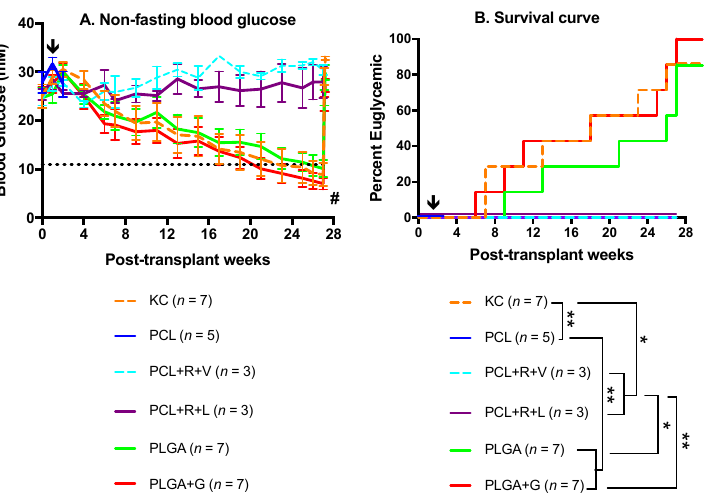
Figure 3. Metabolic follow-up of diabetic B6.129S7-Rag1 tm1Mom/J –immunodeficient mice transplanted with neonatal porcine islets (3000 NPIs) under the KC or subcutaneously with PCL, PCL + R + V, PCL + R + L, PLGA or PLGA + G scaffolds. KC transplant recipients were included as a positive control. Mice were monitored for weekly non-fasting blood glucose ( A ) and were analyzed for their percent euglycemic ( B ). PLGA + G (7/7) recipients achieved euglycemia while PLGA (6/7) and KC (6/7) recipients achieved euglycemia ( p > 0.05, log-rank). In contrast, none of the recipients normalized in PCL (0/5), PCL + R + V (0/3) or PCL + R + L (0/3) (* p < 0.05, ** p < 0.01, log-rank). # indicates graft retrieved, at which point mice reverted back to their pre-transplant hyperglycemic level in the non-fasting blood glucose graph, indicating survival nephrectomy or subcutaneous graft explantation. Arrows indicate that recipients of the PCL group ( n = 5) were electively euthanized at two weeks post-transplant due to poor health conditions.